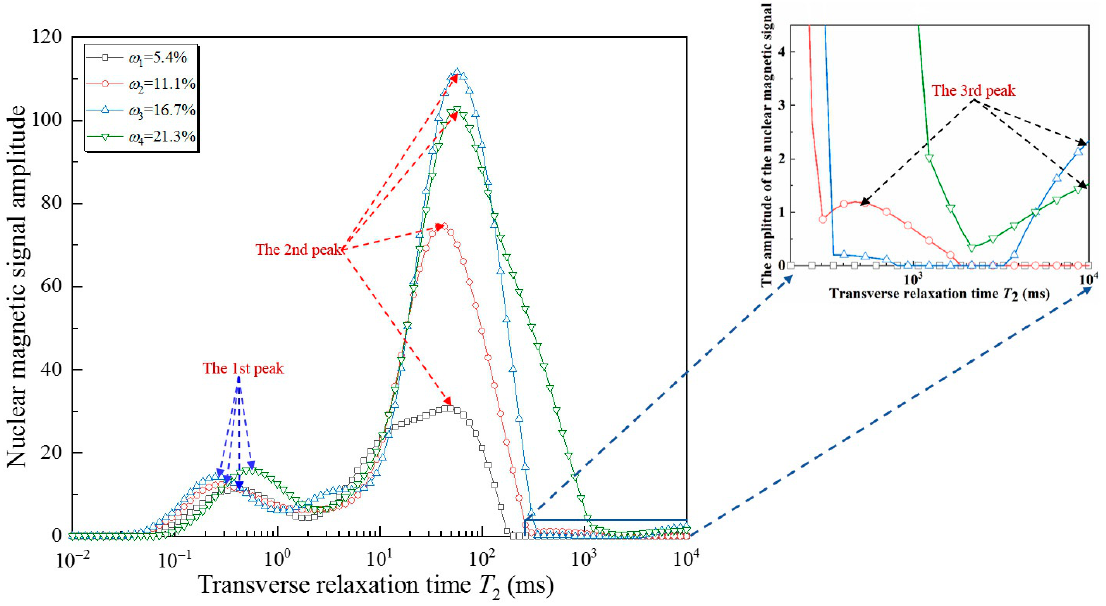
Figure 8. T 2 distribution curves of coral gravelly sand with different water contents.